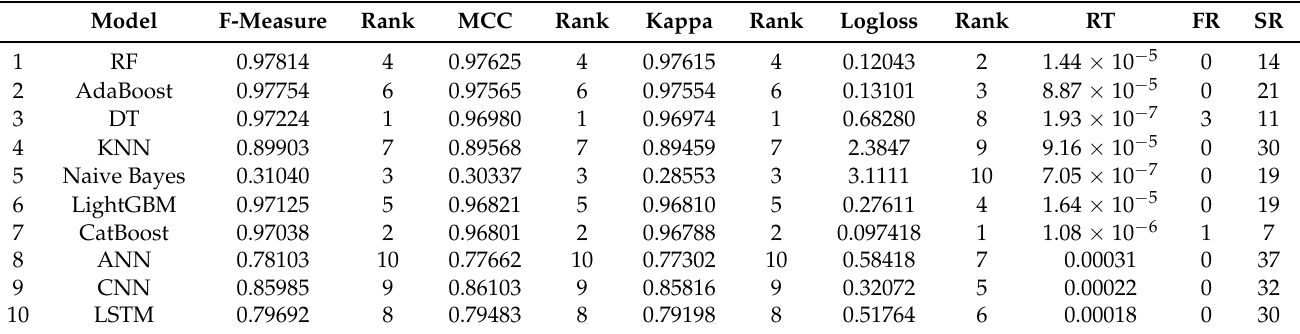
Table 8. Ranking of detection model using the Merged dataset for